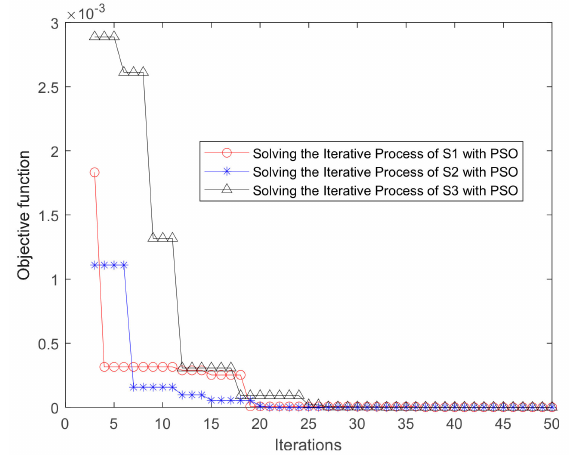
Figure 6. Iterative particle swarm optimization (PSO)